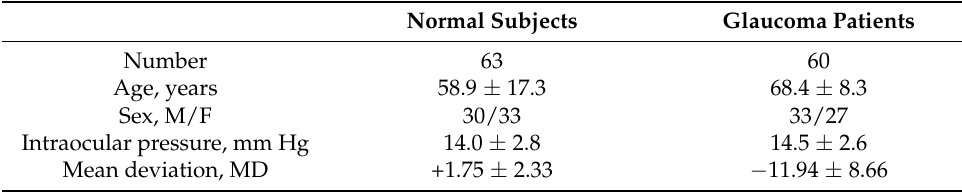
Table 1. Demographics of the study population.